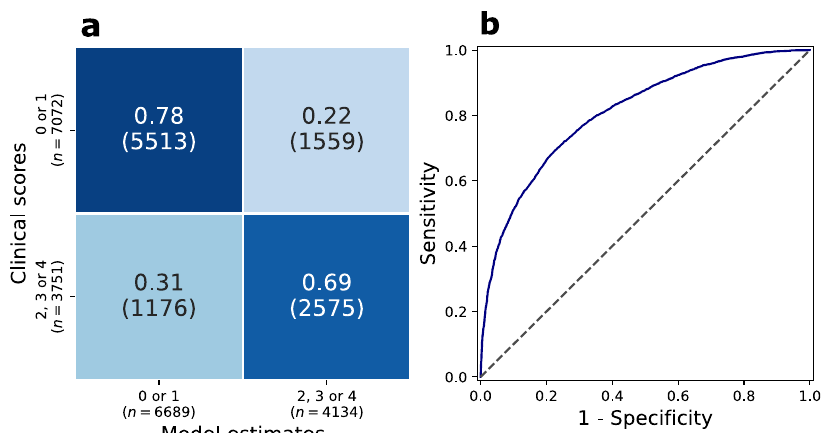
Fig. 5 Summary of binary classi fi cation model results. a Confusion matrix of a binary classi fi er to distinguish low-mild versus moderate-high severity ratings ({0, 1} vs {2, 3, 4}), which has the accuracy of 75%. b Receiver operator characteristic curve of this classi fi er. The area under the curve is